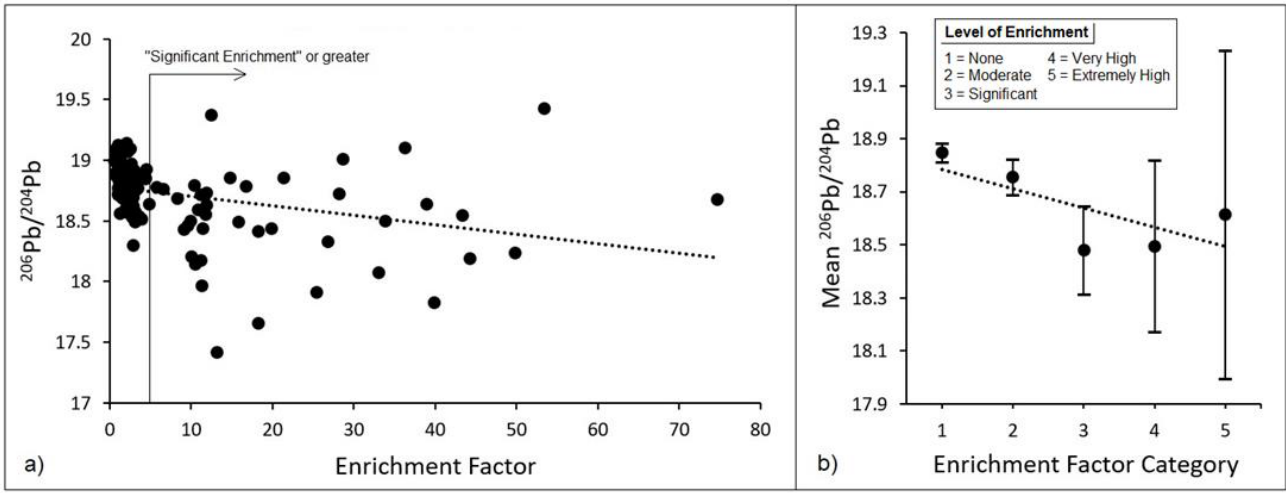
Figure 4. Ratio of ( a ) 206 Pb/ 204 Pb plotted against Pb enrichment factors as measured in the soil,